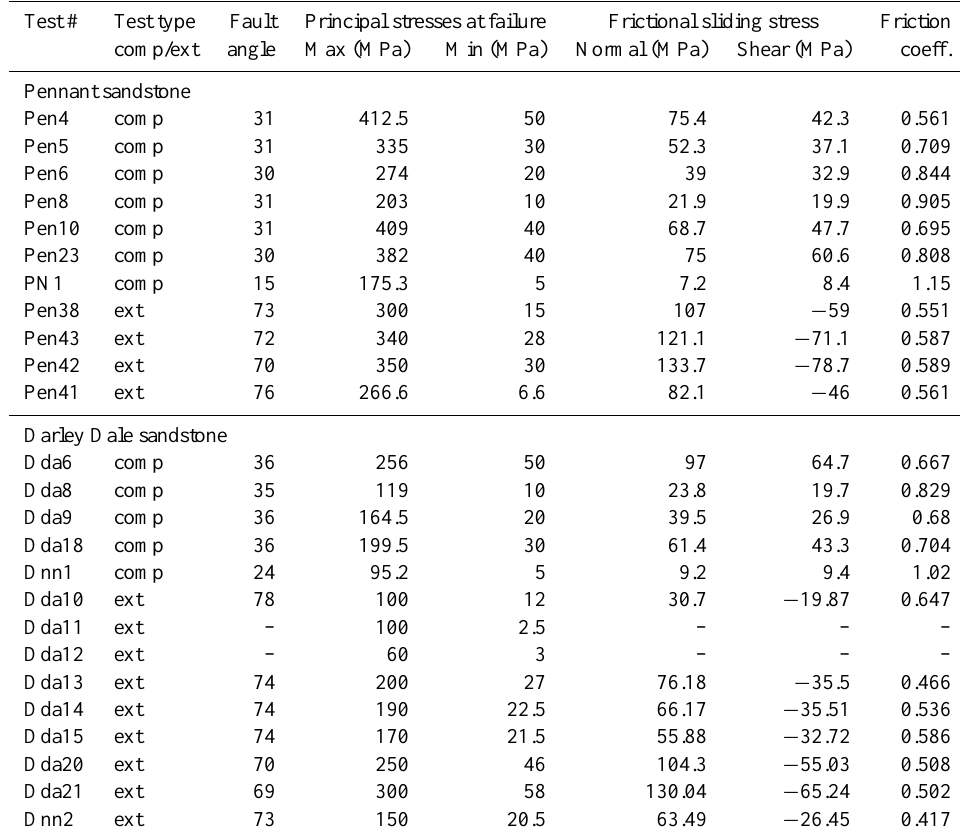
Figure 7. Optical photomicrographs (crossed polars with gypsum plate) of faulted, initially intact samples of Darley Dale sandstone (a) DDa9 (30 MPa confining pressure, shortening) and (b) DDa13 (170 MPa confining pressure, extension). In each case the cylinder long axis is vertical and intensely granulated material has been lost from the fault zone in the sectioning process. Axial transgranular extension cracks have formed in the grains adjacent to the fault zone and these reveal the local orientation of maximum compressive stress σ 1 . In (a) the σ 1 direction remains parallel to the cylinder axis, at a high angle to the fault plane. In (b) the σ 1 direction is locally refracted towards the fault plane, which makes a relatively small angle with the far-field σ 1 direction. Table 1. Tests on intact rock cylinders. Fault angle is measured from cylinder axis. Axial displacement rate is 0.05mmmin − 1 . Shear stresses are negative in